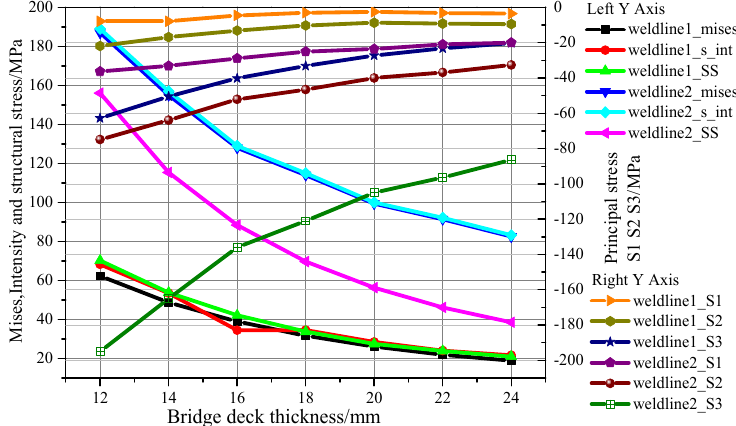
Figure 22. Trends of various stresses with the radius of the weld seam.